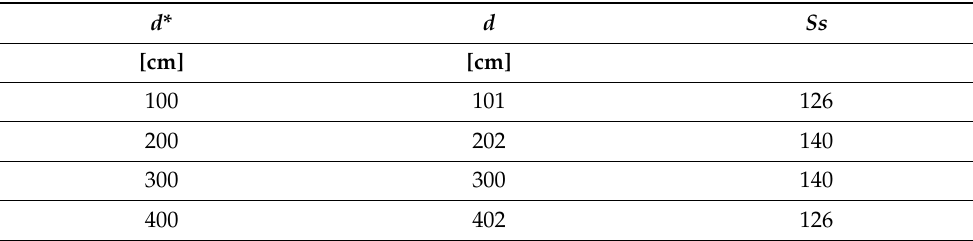
Table 9. Different lighting conditions experimental results.